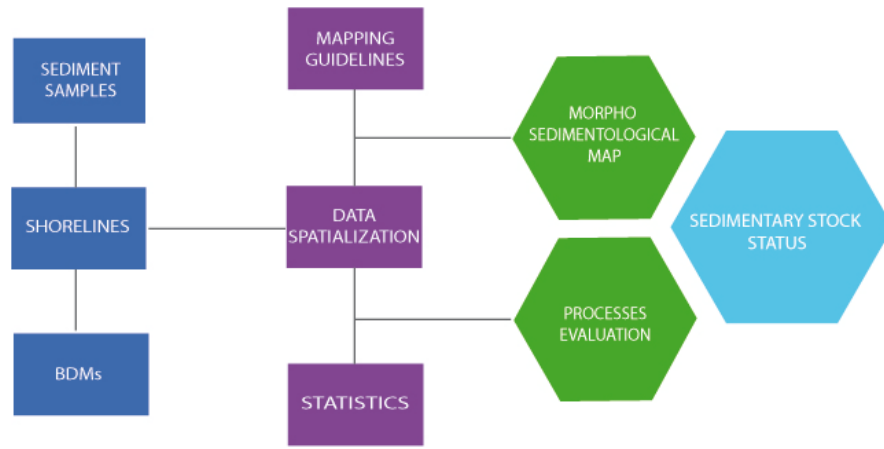
Figure 6. Workflow followed for sedimentary stock analysis.